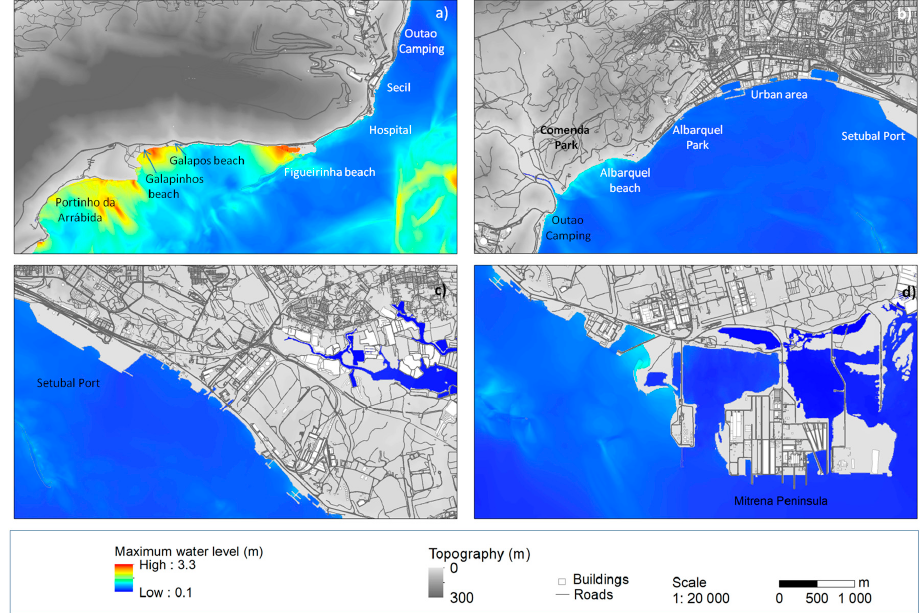
Figure 8. Maximum water level of the 1969 tsunami: ( a ) Western area; ( b ) Central area, including the urban area; ( c ) Eastern area, including the industrial area; ( d ) South-east area where the Mitrena Peninsula is located.